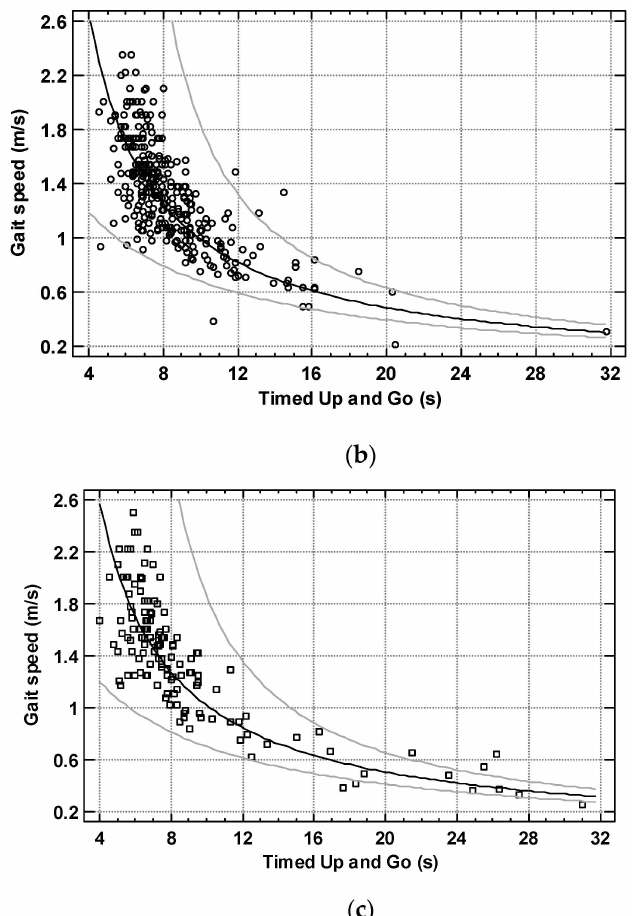
Figure 1. ( a ) the relationship of Timed Up and Go to gait speed in 450 subjects (regression line, 95% prediction limits); ( b ) the relationship of Timed Up and Go to gait speed in 315 women (regression line, 95% prediction limits); ( c ). the relationship of Timed Up and Go to gait speed in 135 men (regression line, 95% prediction